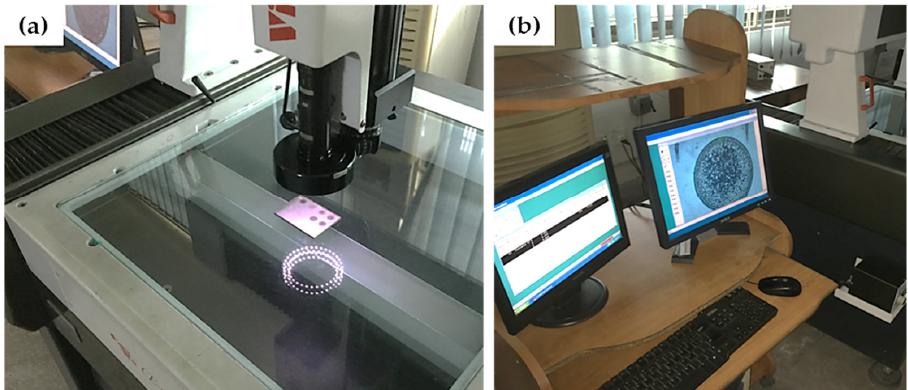
Figure 3. Coordinate measuring machine: ( a ) workpiece setting on CMM, ( b ) dimensional measurement of machined surfaces.